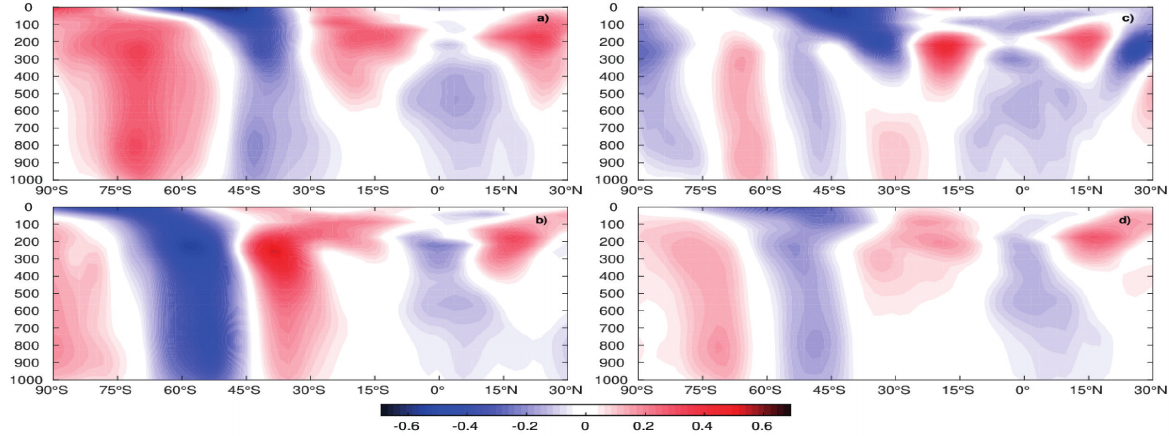
Figure 3. Differences between the layermax-layerctl experiments for the zonal mean (from 90°S to 30°N) wind profile (ms -1 ) for the Atlantic sector (from 65°W to 15°E) during the periods: a) July 2020–June 2024; b) July